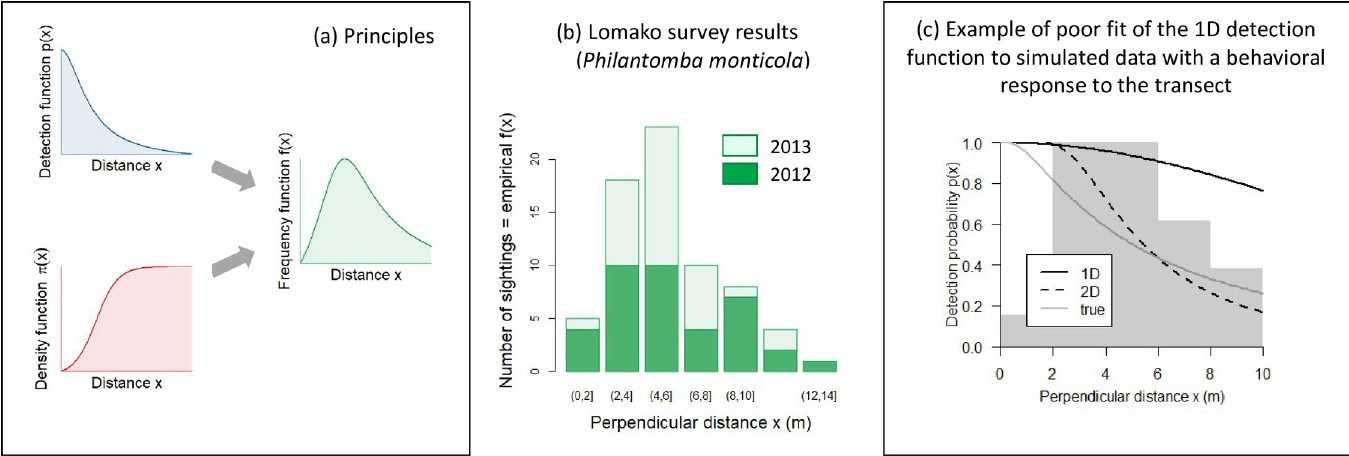
Fig 1. When the animals avoid the transect or the observer, there can be a peak in sightings at intermediate distances (panel a: theoretical principles; panel b: empirical observation). This pattern causes a lack of fit of the standard, 1D distance sampling detection function (panel c; the grey histogram is the density of sightings), because that function wrongly assumes a detection rate of 1 on the transect and a monotonous decline in the frequency of sightings with the distance to the transect.